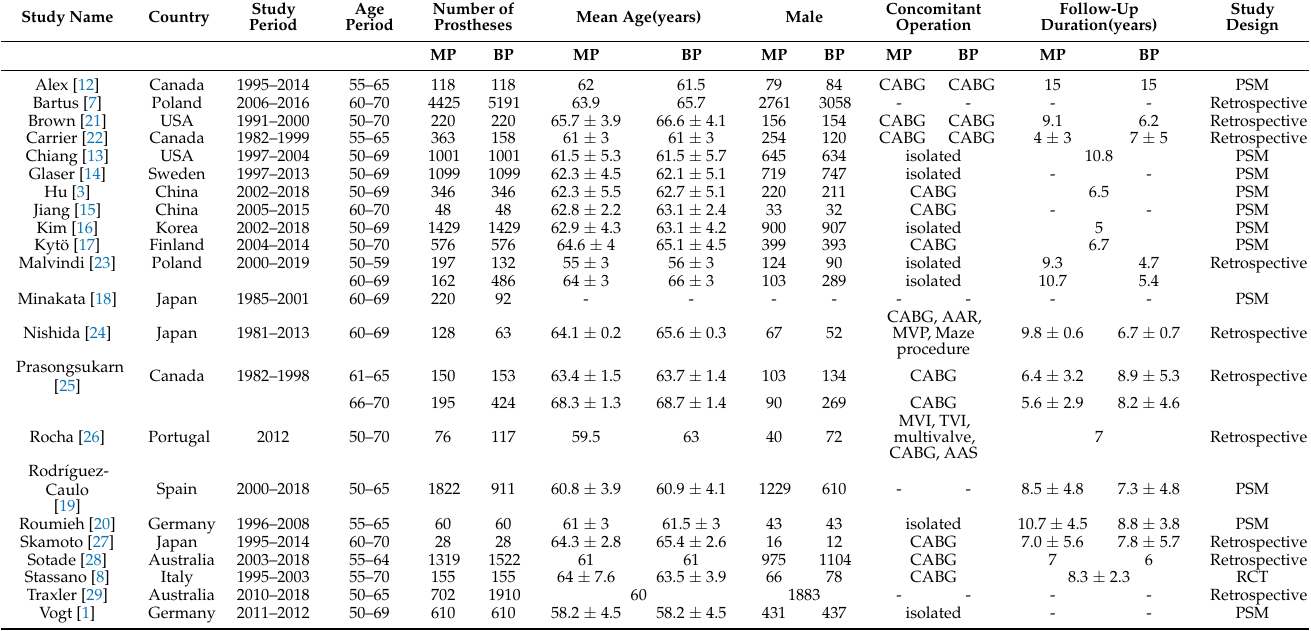
Figure 1. The flowchart outlining the literature search process. Table 1. The characteristics of the individual studies.